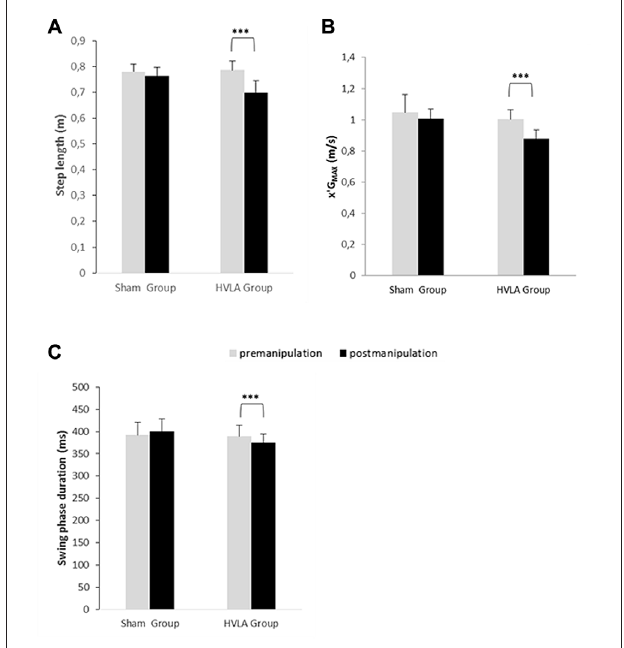
FIGURE 6 | Comparison of swing phase-related parameters of gait initiation between the pre- and post-manipulation conditions in the sham and HVLA groups. (A) Step length, (B) x (cid:48) G MAX : peak center of gravity velocity and (C) swing phase duration. ∗∗∗ Statistical difference with p < 0.01, p < 0.001, respectively. Values given are means ± 1 standard